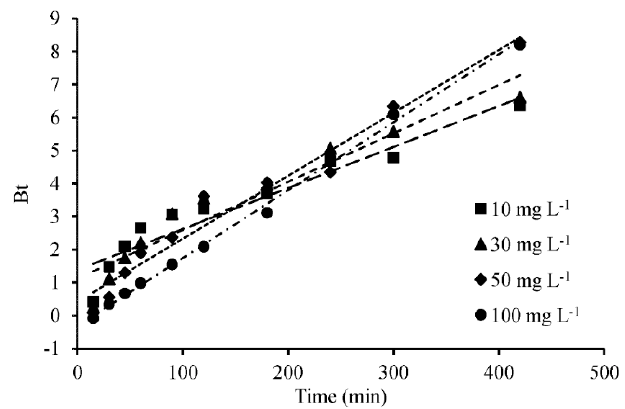
Figure 7. Intra-particle diffusion model plots for the RR120 adsorption on the MCC.